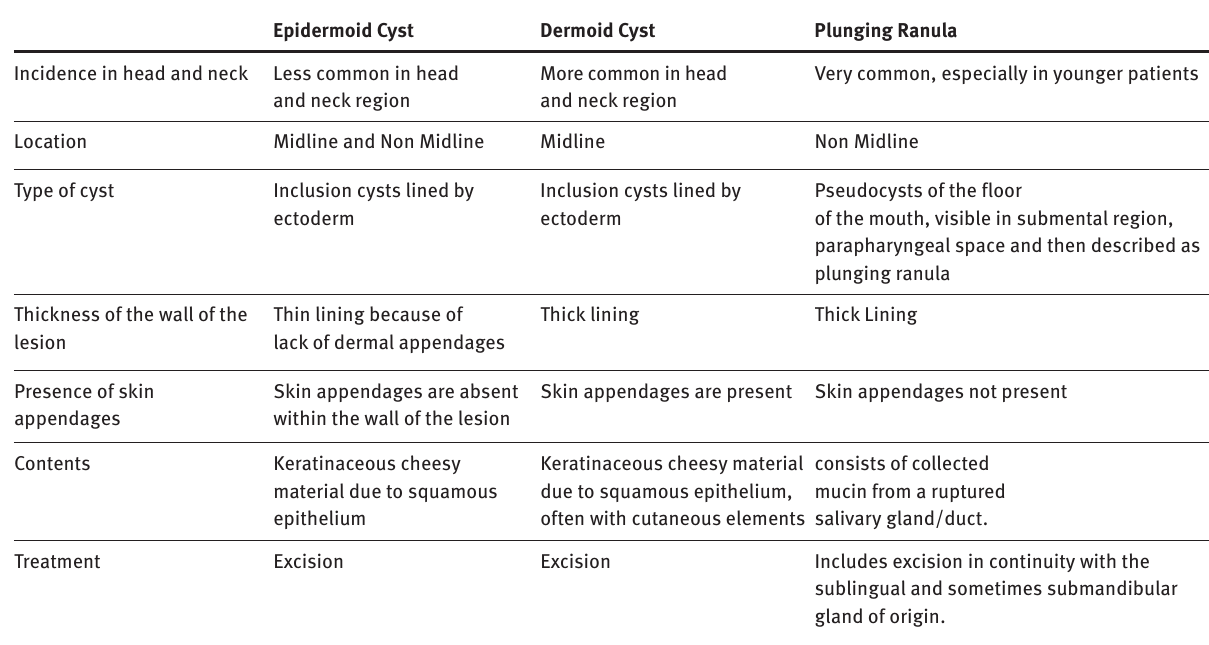
Table 1: Differential diagnosis of submental cystic lesions